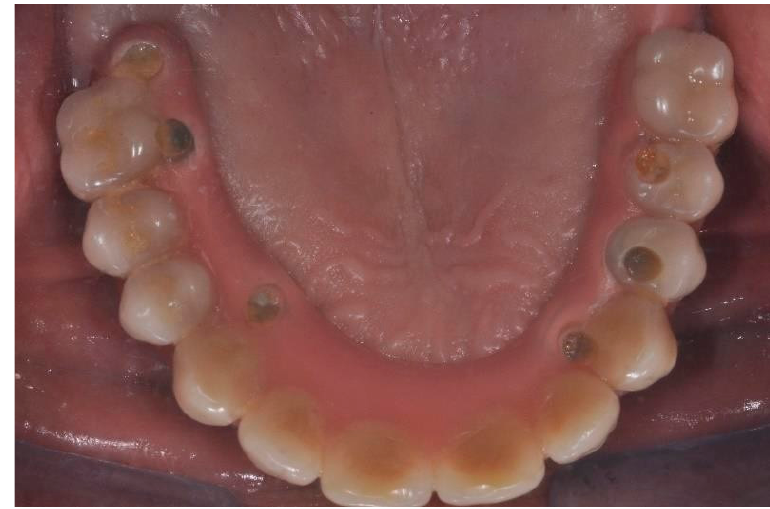
Figure 6. Occlusal view of the prosthetic rehabilitation.